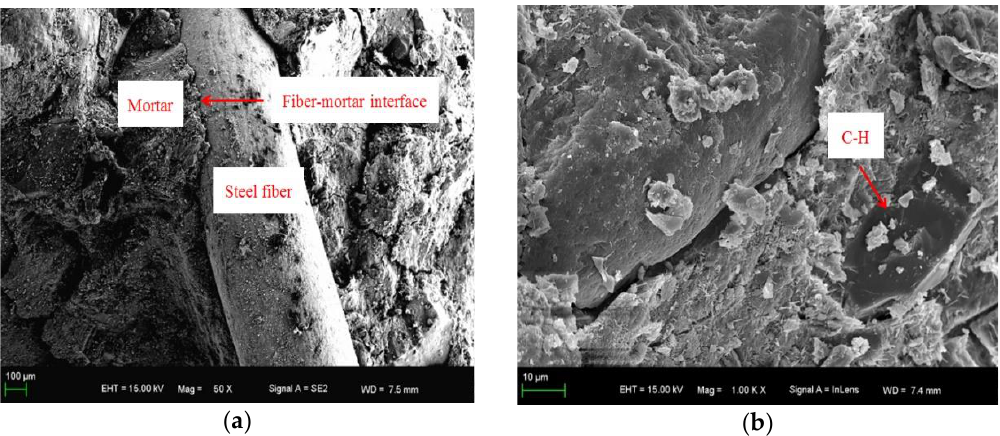
Figure 23. Micromorphology of ITZ between steel fiber and matrix of SF10 specimen. (a) ITZ mi- cromorphology and (b) C – H gels. micromorphology and ( b ) C–H